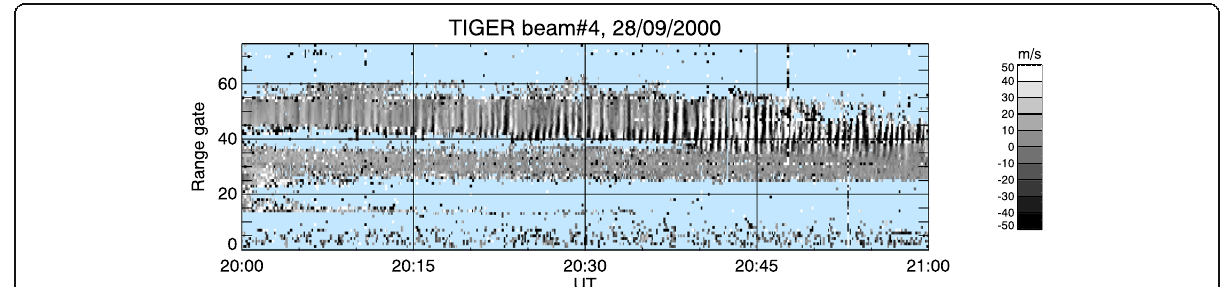
Fig. 36 LOS velocity data from beam 4 of TIG as a function of range and UT. One hour of LOS velocity data is presented from 2000 to 2100 UT on 28 September 2000. The gray scale, which saturates at + 50 m s − 1 and − 50 m s − 1 , demonstrates the ability of this technique to visualize MHD waves in the data. Note also the band of scatter between range gates 20 and 40 (which is probably ground scatter) shows no evidence of the MHD wave on this occasion. Based on Fig. 4 of Ponomarenko et al.